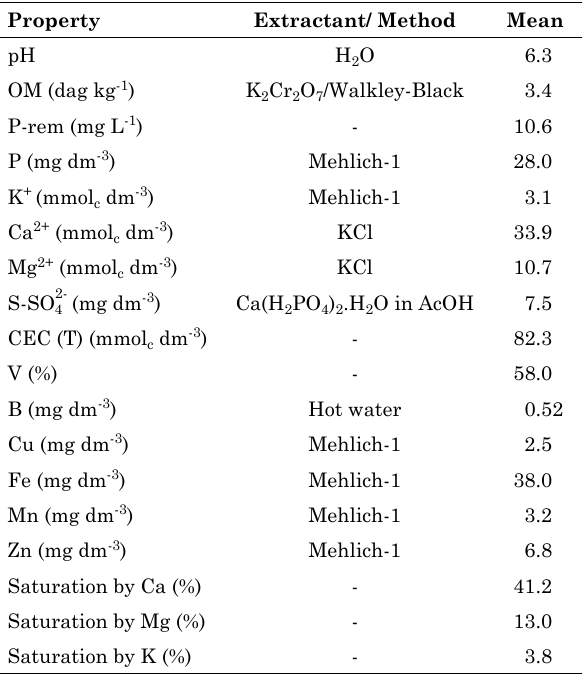
table 4. chemical properties of the soil used in simulations of fertilizer recommendation by ferticalc carrot